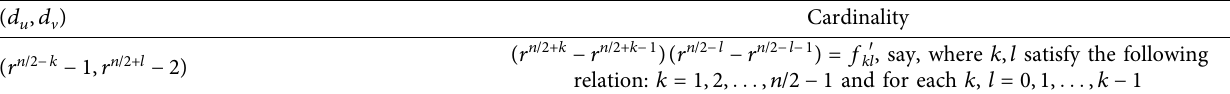
Table 10: Partition of pair of nodes ( u, v ) having distance 2.